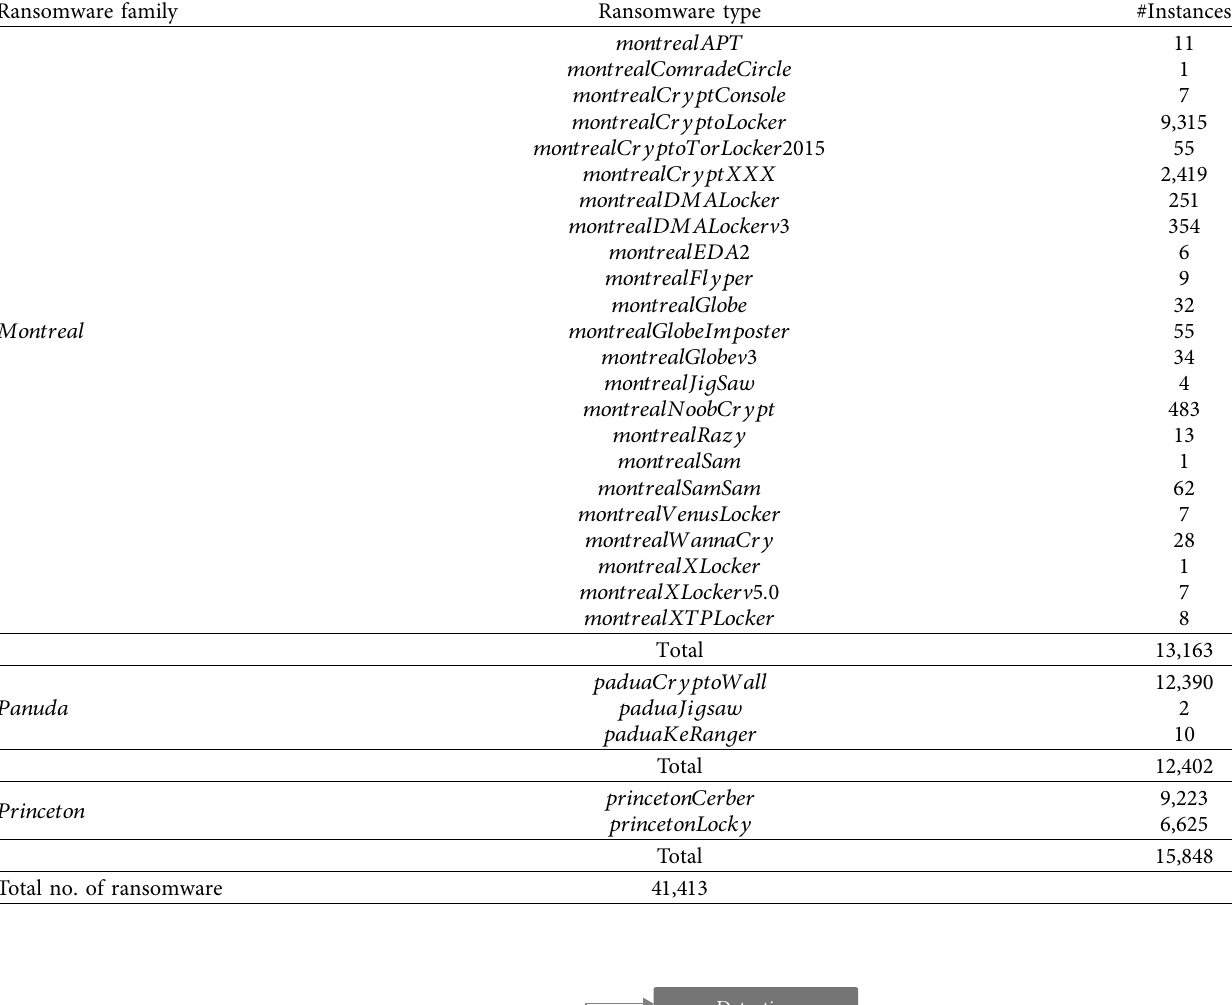
Table 1: Bitcoin transactions dataset statistics.